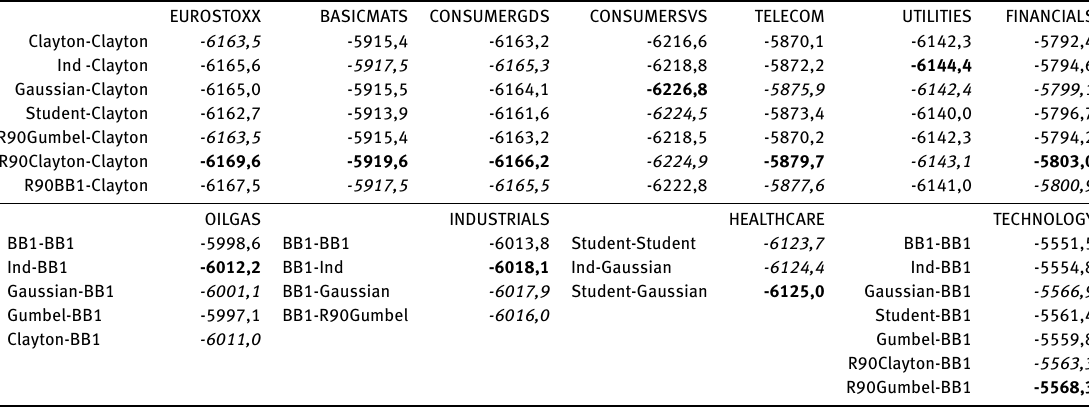
Table 6: AICC values for the models with different copula